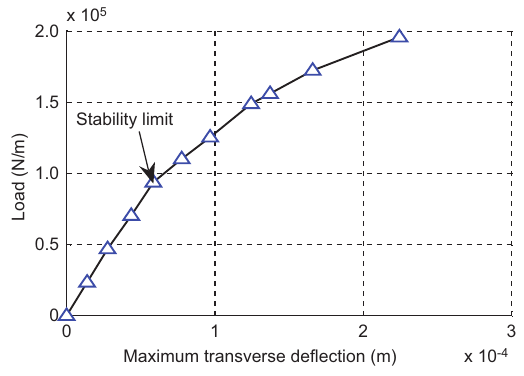
Figure 3 Load defl ection curve for clamped-clamped tapered curved plate.